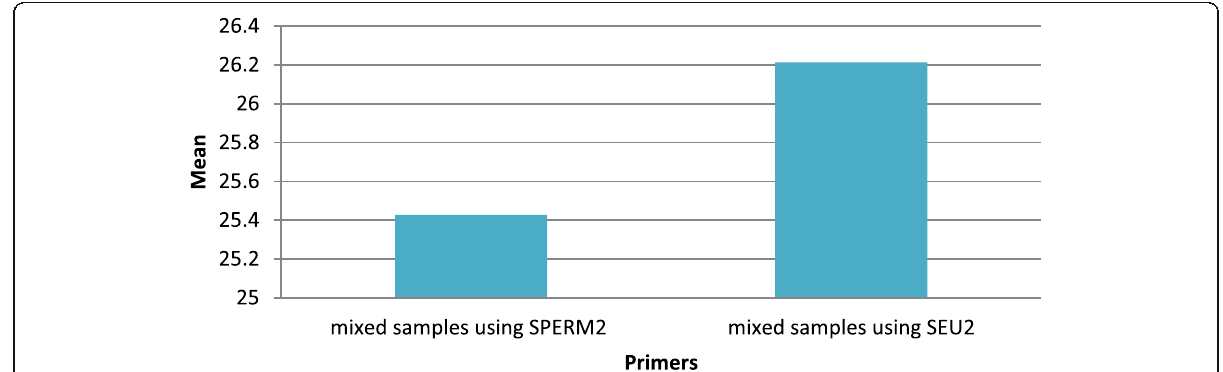
Fig. 3 Comparison between the mean of Cq values of SPERM2 and SEU2 methylation markers in biological